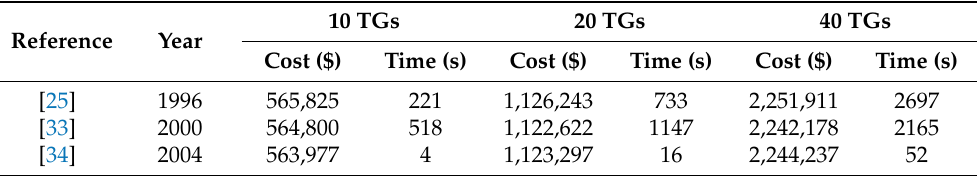
Table 12. Literature